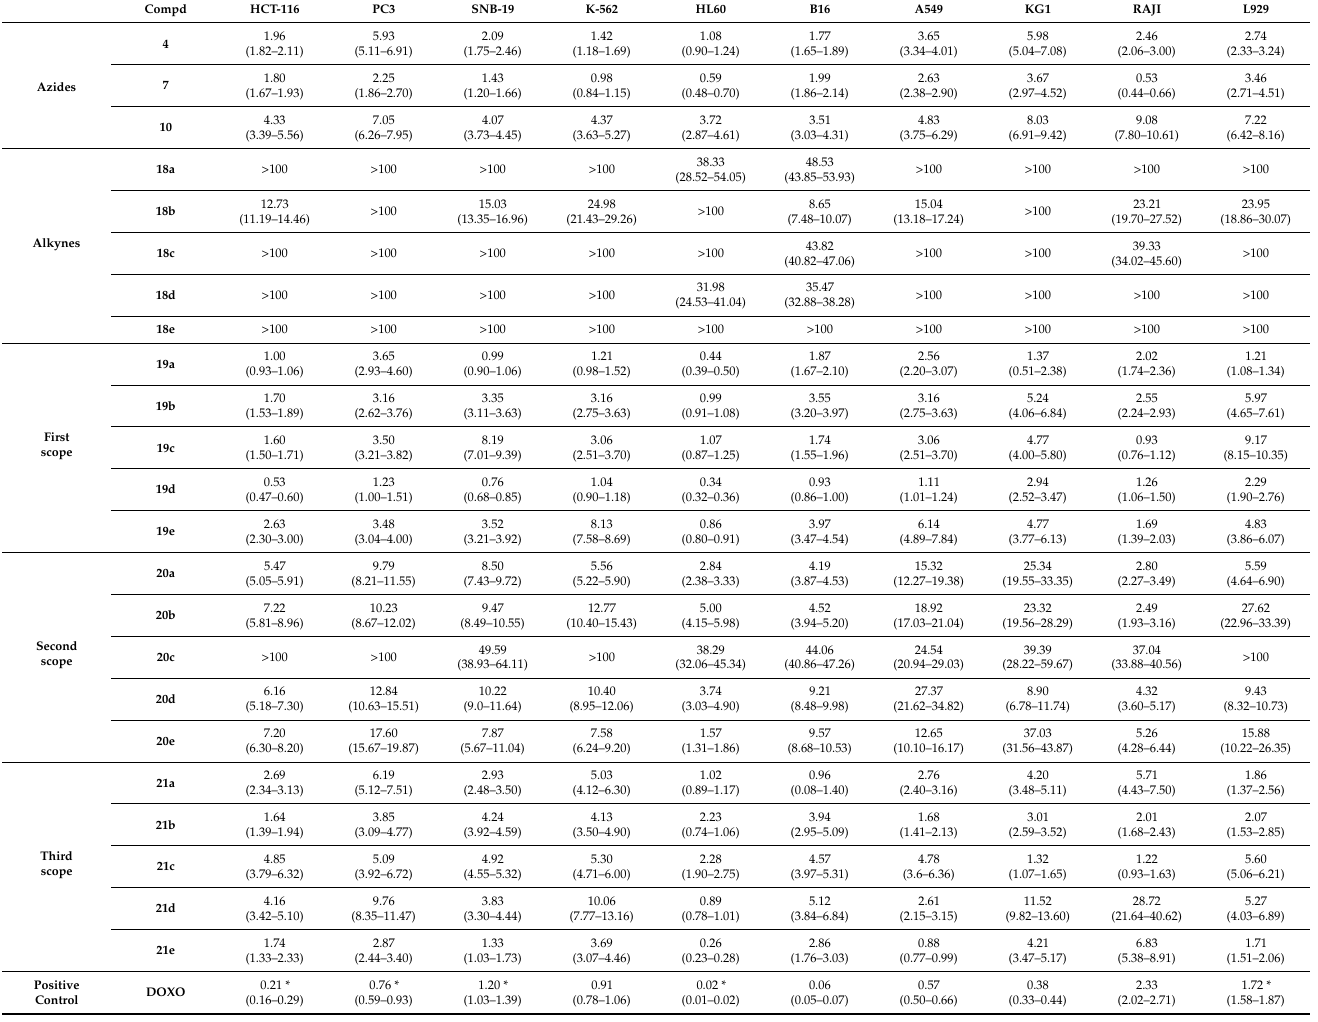
Table 1. Cytotoxic activity expressed as IC 50 µ M (95% CI) against cancer and normal cell lines after 72 h exposure, obtained using nonlinear regression for all cell lines from three independent experiments. * Data previously described [32]. DOXO = doxorubicin.